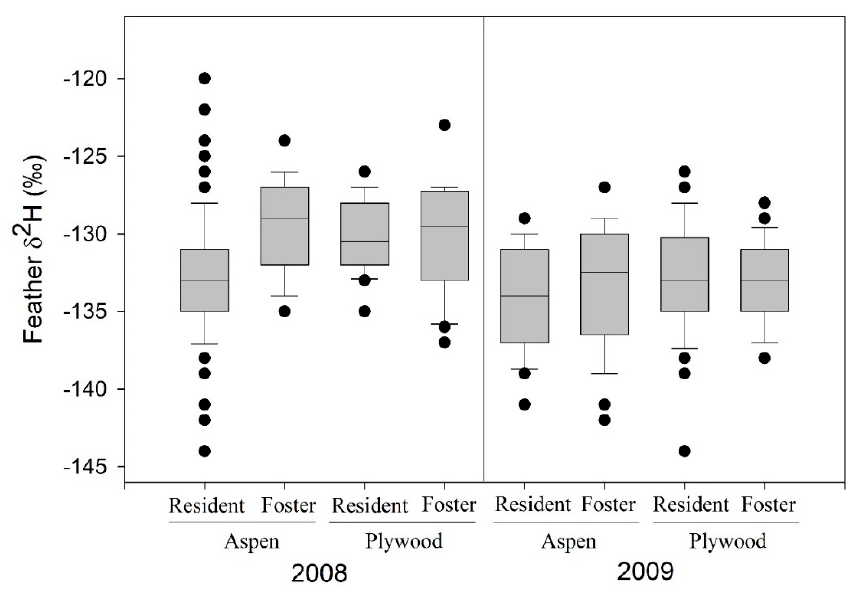
Figure 1. Feather δ 2 H values (‰) for resident and cross-fostered nestling tree swallows at St. Denis, Saskatchewan, 2008 ( n = 96) and 2009 ( n = 136), in relation to nest box type of rearing (aspen, plywood). Boxplot shows median (horizontal line), 25% and 75% values (lower and upper edges of shaded box), 5% and 95% values (horizontal whiskers), and extreme values (filled circles). Table 1. Results of mixed-effects models for δ 2 H, δ 13 C, and δ 15 N values in feathers of wild tree swallows and American kestrels. 1 Feather δ 2 H was measured over two years only in swallows at the SK site. Cross-foster refers to whether or not a nestling was cross-fostered, and box type refers to aspen versus plywood boxes (SK only). Shown are model F values for fixed effects, z values for random terms, and number of nestlings ( n ), of which ~50% were cross-fostered.